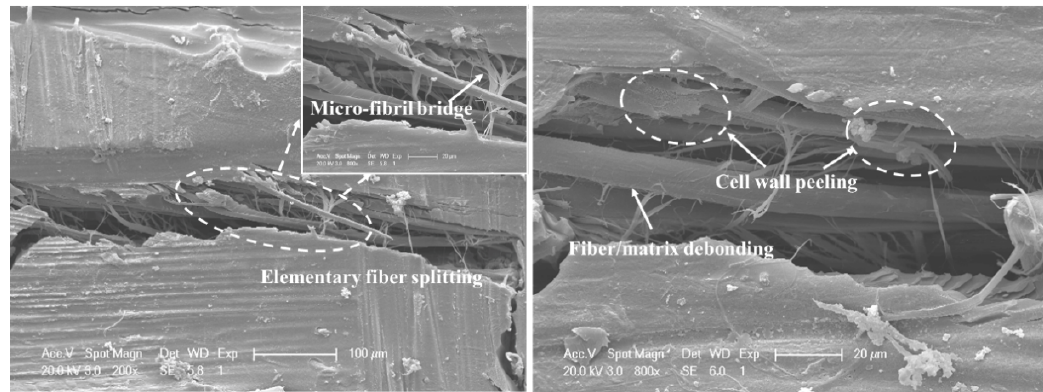
Figure 9. Micrograph of damage initiation modes for the FFRP following impact test at 140 ◦